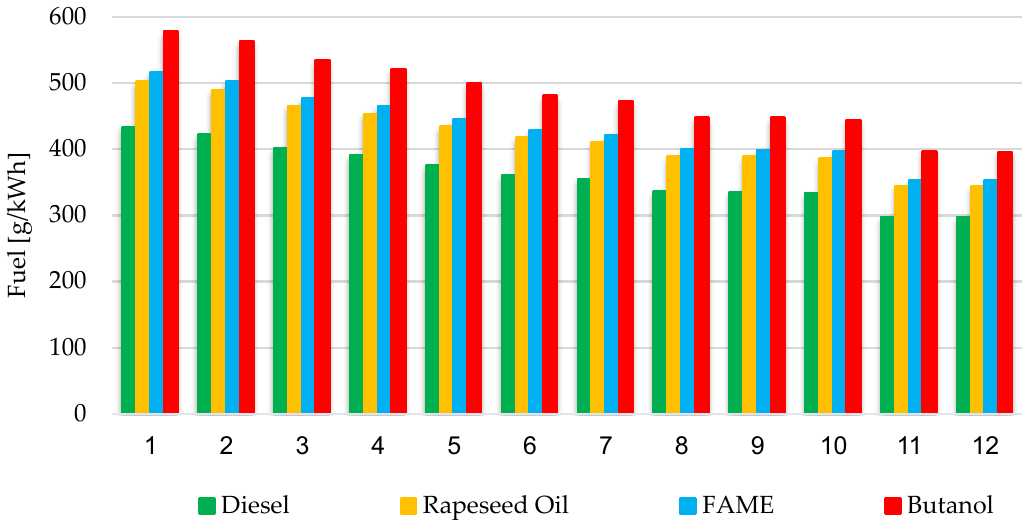
Figure 14. Summary of fuel mass consumption in tests per 1 kilowatt hour: 1—FTP 75; 2—NEDC; 3—Random Cycle Low (x05); 4—US SC03; 5—CADC without MOT; 6—WLTC 3b random; 7—MAC TP cycle; 8—US highway; 9—CADC shortened; 10—CADC; 11—US 06; 12—Random Cycle High (x95).